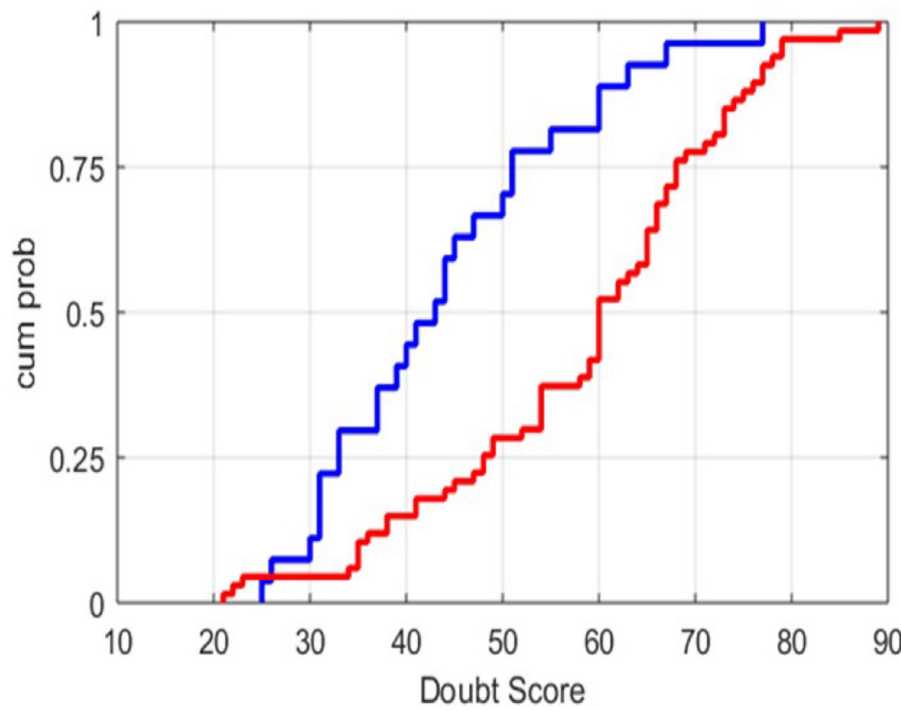
Fig 2. Cumulative probability distributions of doubt scores in OCD and non-OCD participants. OCD (red color; N = 67); non-OCD participants (blue color; N = 27). Participants with OCD exhibited significantly higher doubt scores (rank sum test, p <